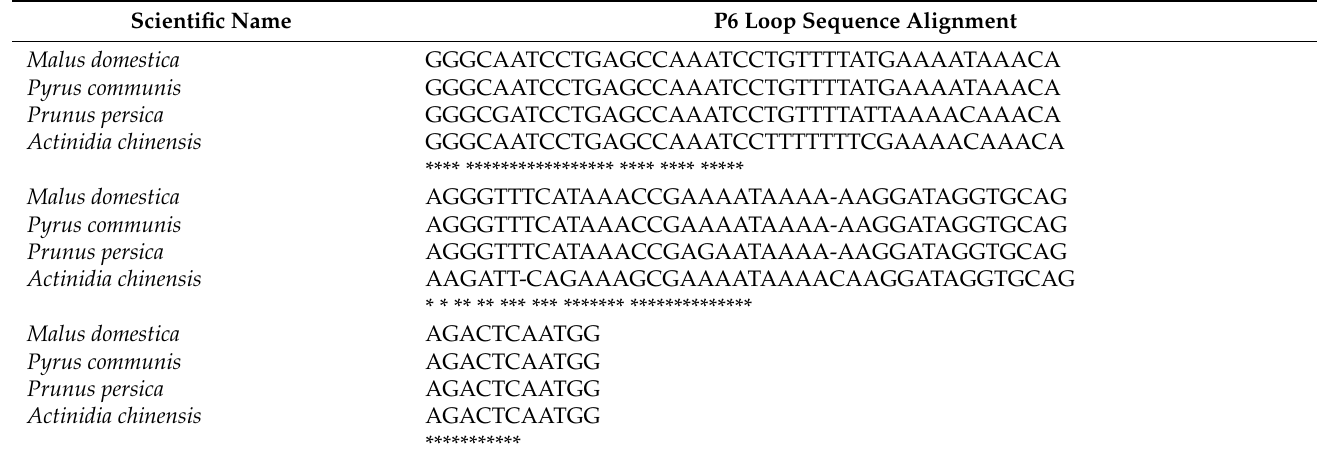
Table 2. ClustalW alignment of P6 loop fragment of sequenced pear fragment with pear present in